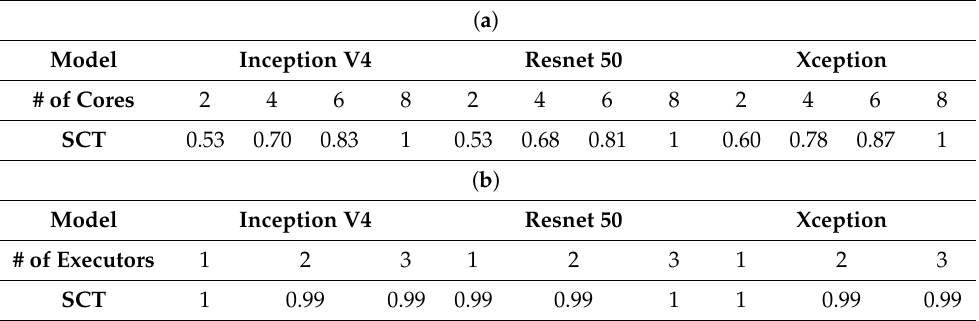
Table 6. E ff ect of the number of cores on the SCT of each CNN